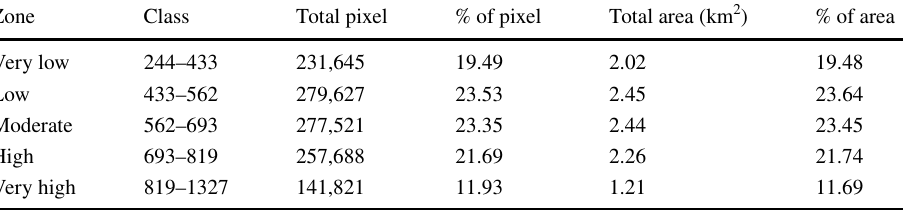
Table 4 Flood vulnerability zone of Kulik river basin and area under different sub-zones